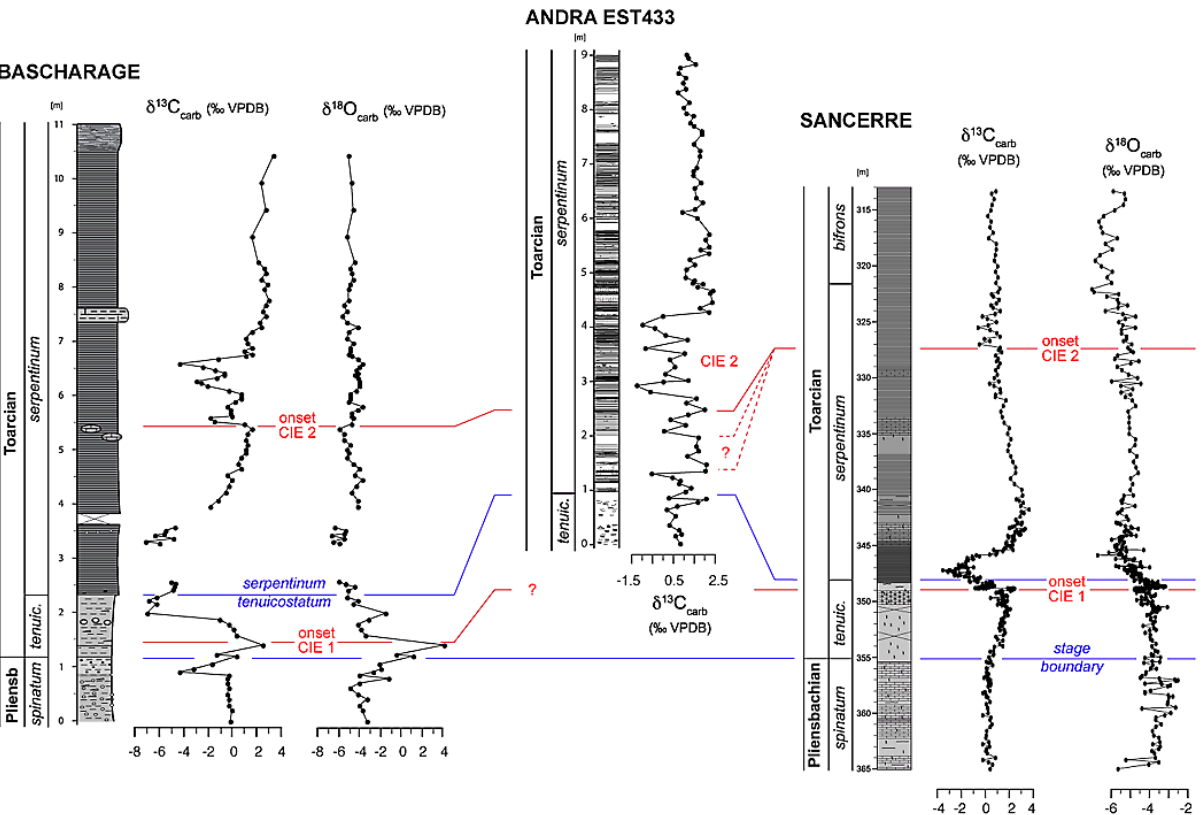
Figure 7. Attempt of a biostratigraphic and chemostratigraphic correlation of three well-documented Lower Toarcian sections of the Paris Basin. Blue lines indicate tentative biostratigraphic correlations. Red lines represent tentative chemostratigraphic correlations based on carbon isotope curves, and pinpoint the onsets of negative carbon isotope excursions. Two distinct CIEs are apparent: the first one (CIE 1) in the tenuicostatum zone (hence, correlated to the “worldwide” T-CIE), and the subsequent one (CIE 2) in the serpentinum zone. Data source: Bascharage (present study), EST433 (Lézin et al., 2013), Sancerre (Hermoso and Pellenard, 2014). The palaeogeographic location of each site is shown in Fig. 1a. Note that Sancerre corresponds to a much more expanded section compared to Bascharage and